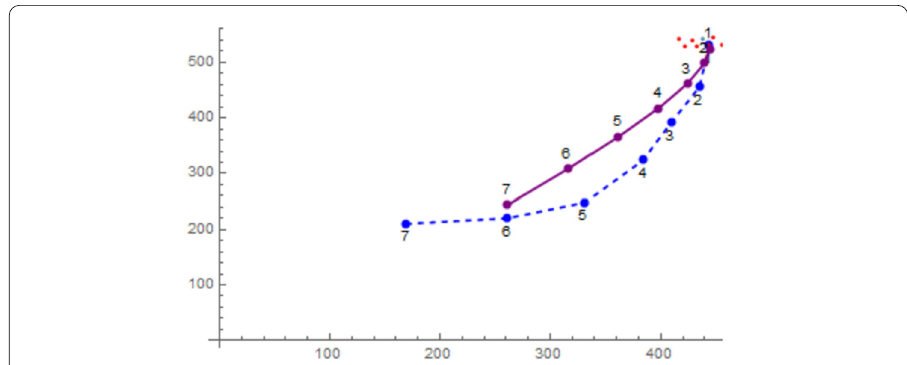
Figure 12 Similarity between the reconstructed tunnel (solid line) and the real tunnel (dashed line). (The red points at the top right are starting